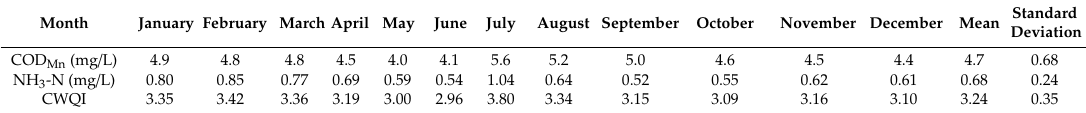
Figure 2. Temporal variations of regional mean COD Mn ( a ), NH 3 -N ( b ), and comprehensive water quality index (CWQI) ( c ). Table 3. Intra-annual variation of water quality.